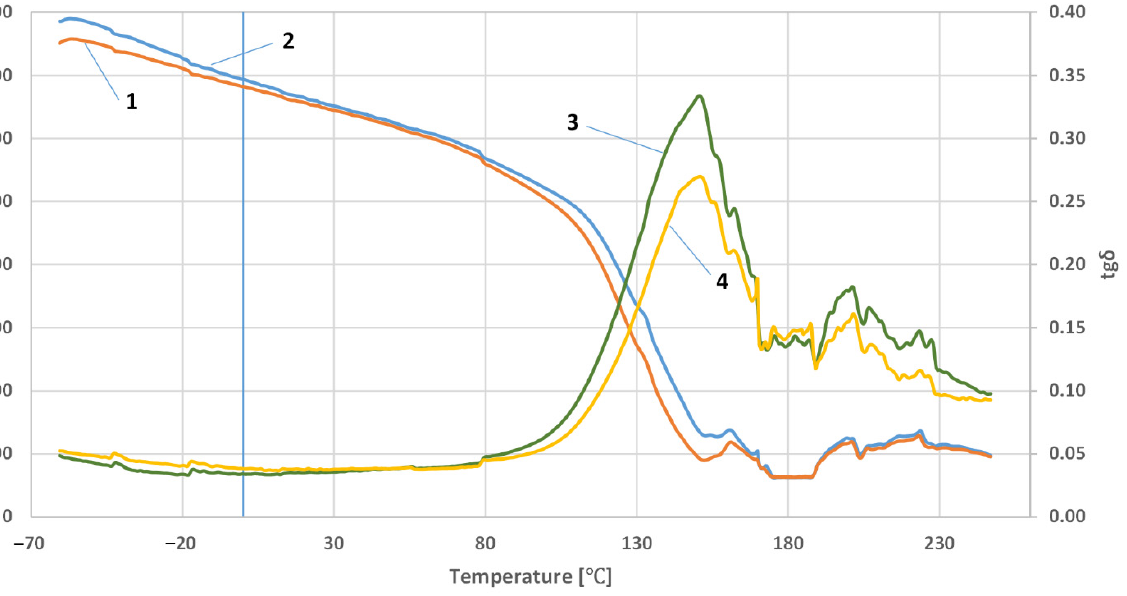
Figure 5. The dependence of the conservative modulus and the tangent of the mechanical loss angle on the resin temperature: at a frequency of 1 Hz—1, 3; at a frequency of 10Hz—2, 4.